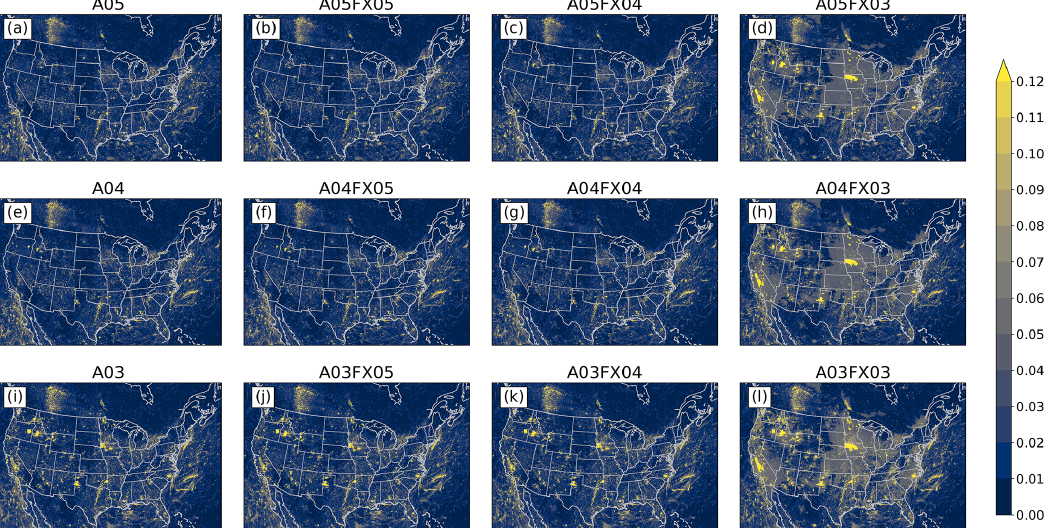
precision 5 cases ( A05FX05, A04FX05, and